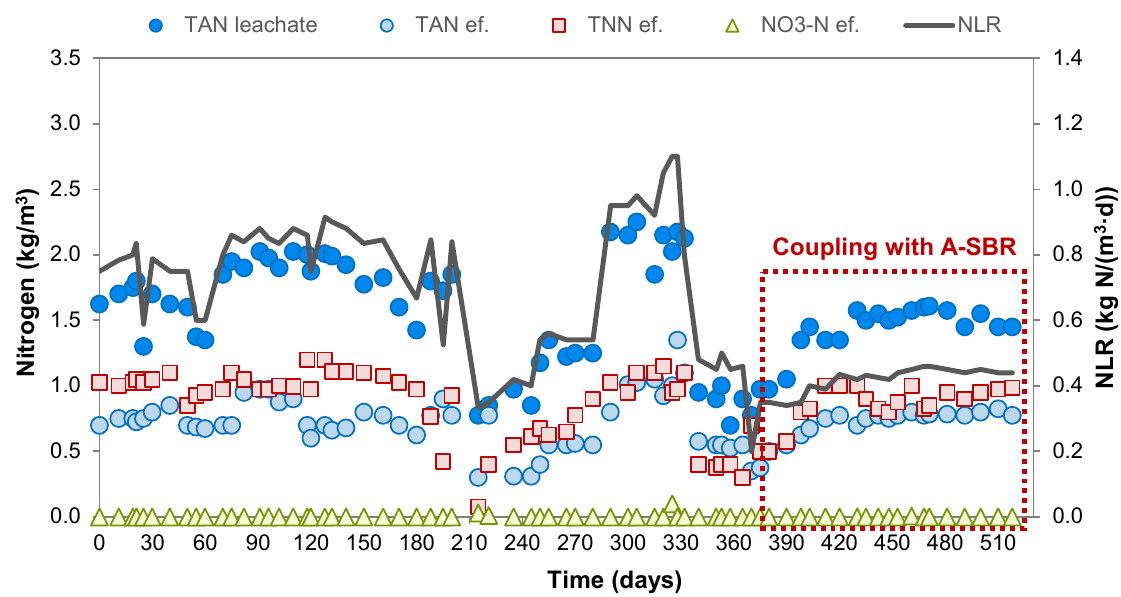
Figure 3. Long-term performance of the pilot-scale PN-SBR treating raw landfill leachate. By the end of the running period, PN-SBR was coupled with A-SBR (see Figure 4, PHASE II-c